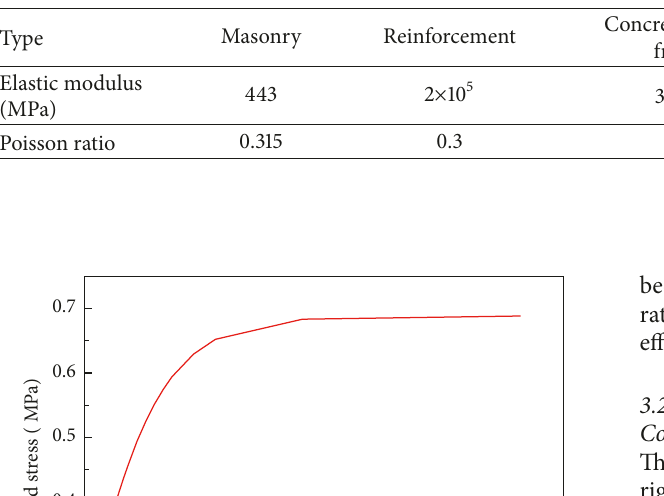
Table 4: Elastic parameters of the materials.